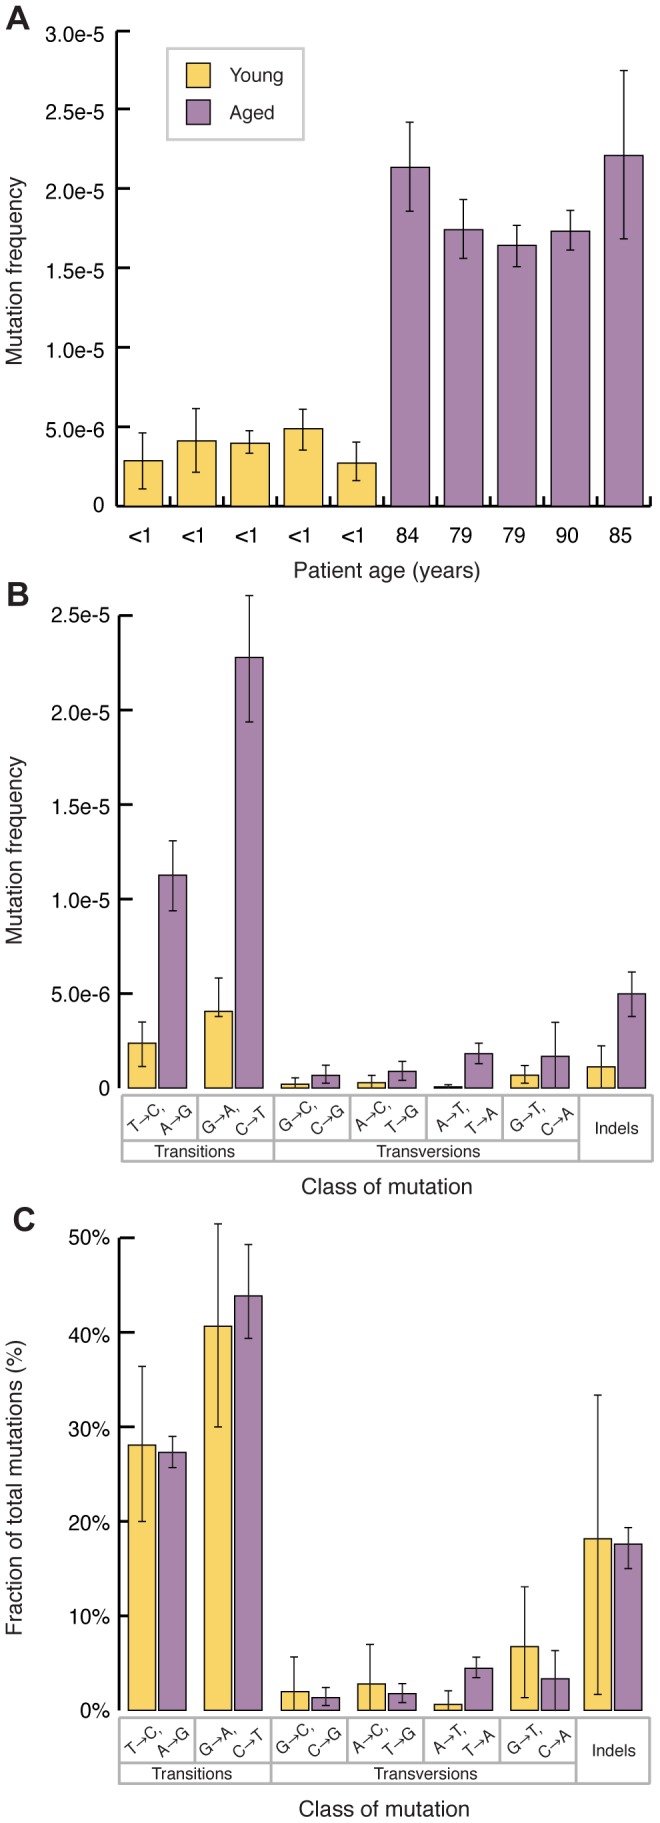
Mitochondrial point mutations increase with age and are biased to transitions.(A) mtDNA point mutations burden is higher in older individuals (purple) than young individuals (yellow) (p<10−4, two-tailed t-test). Error bars represent the 95% confidence interval for each sample (Wilson Score interval) (B) The mutation spectra of both young (yellow) and aged (purple) individuals shows an excess of transitions, relative to transversions. Frequencies were calculated by dividing the number of mutations of each type by the number of times the wild-type base of each mutation type was sequenced. Indels were calculated independently as events per total number of bases sequenced. Error bars represent one standard deviation. (C) The mutation spectra, reported as the relative proportion of the different mutation types, do not change with age. Error bars represent one standard deviation. Significance was tested using the two-tailed t-test.